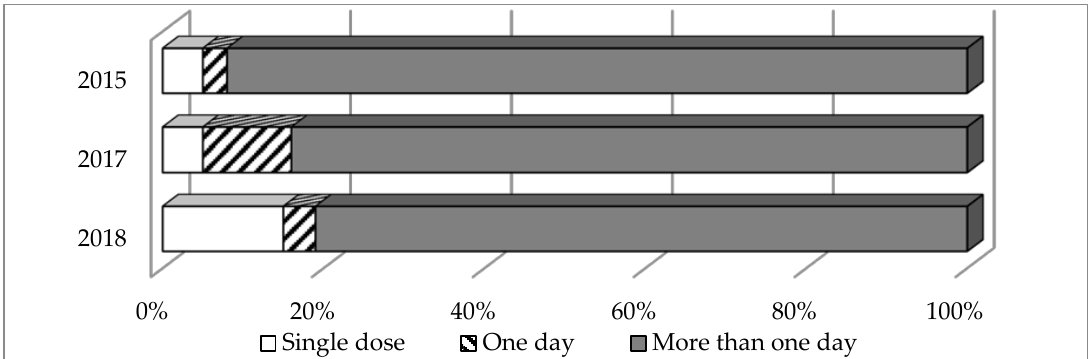
Figure 2. Duration of surgical prophylaxis.